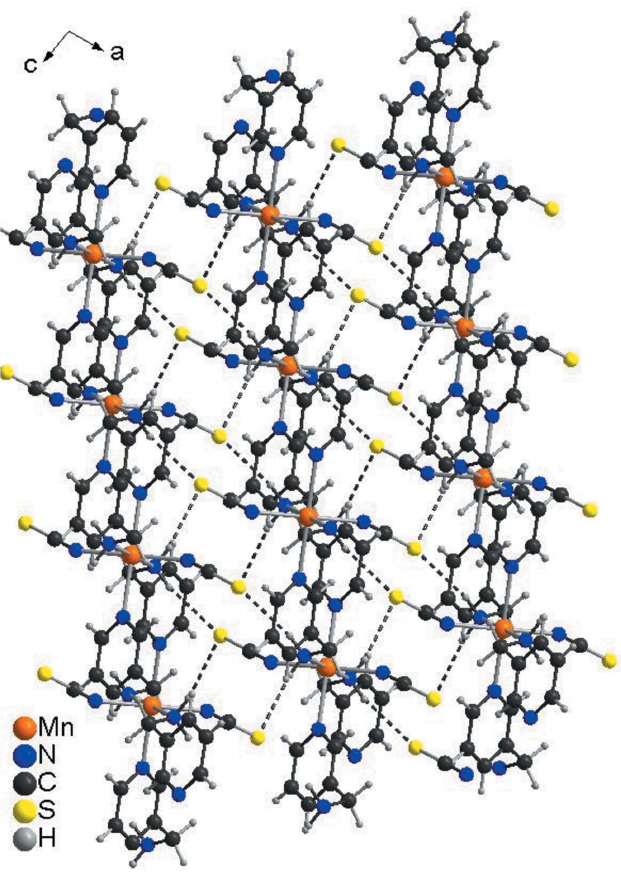
Figure 2 Crystal structure of the title compound in a view of a layer along the crystallographic a axis.